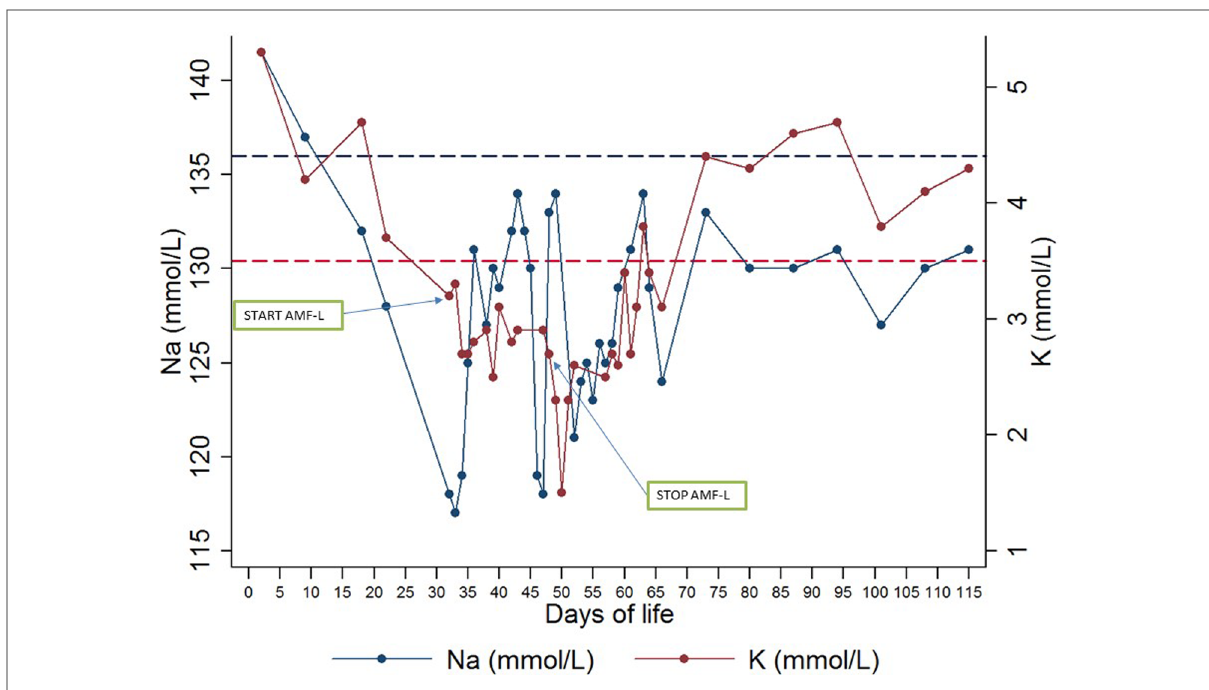
FIGURE 1 Evolution of sodium and potassium over time. Blue dash line: lower limit of hyponatremia. Red dash line: lower limit of